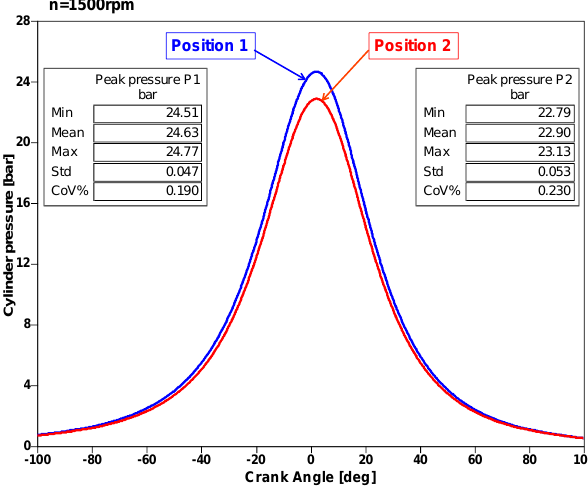
Fig. 19. Cylinder pressure curves for two different intake camshaft modes